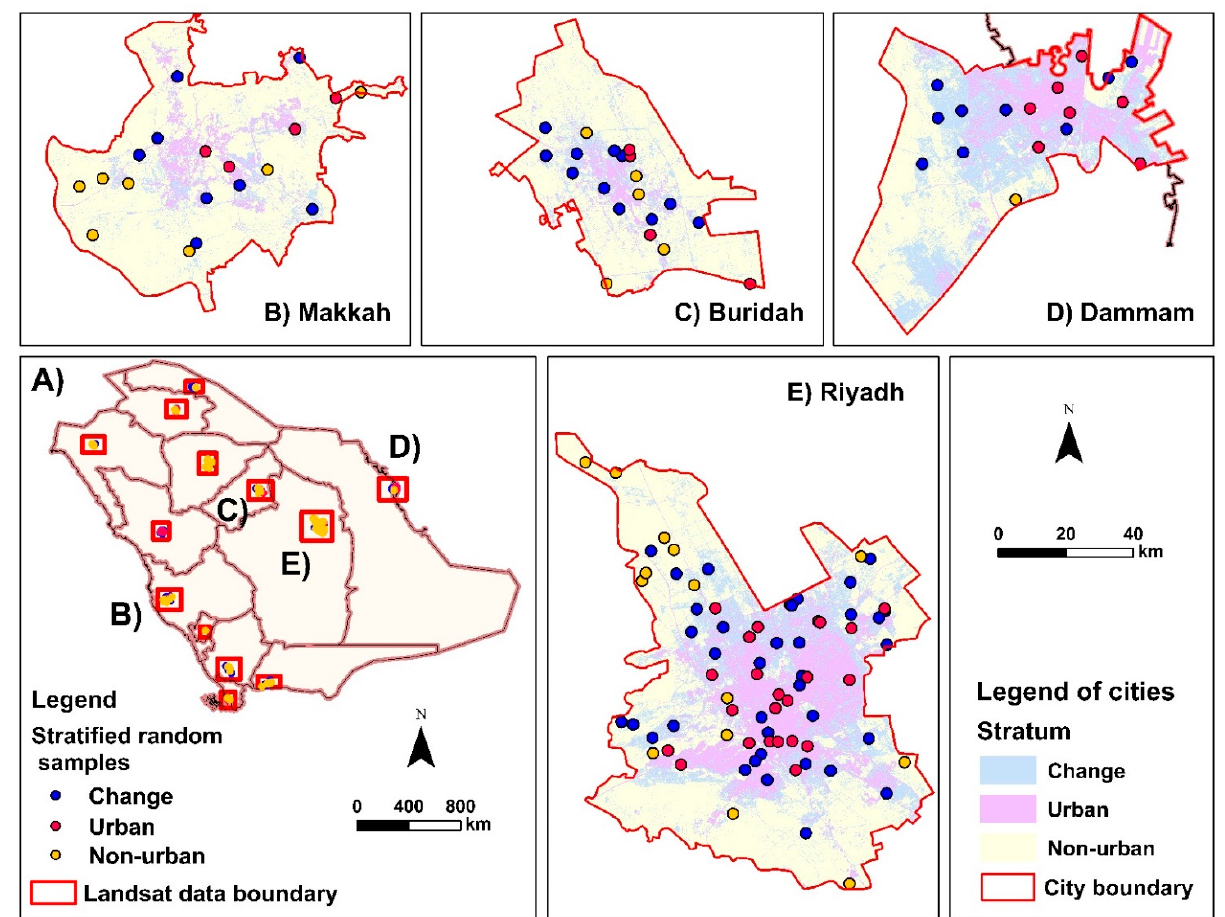
Figure 5. A map of Saudi Arabia ( A ) and the stratified random sampling design maps of four different capitals ( B – E ).